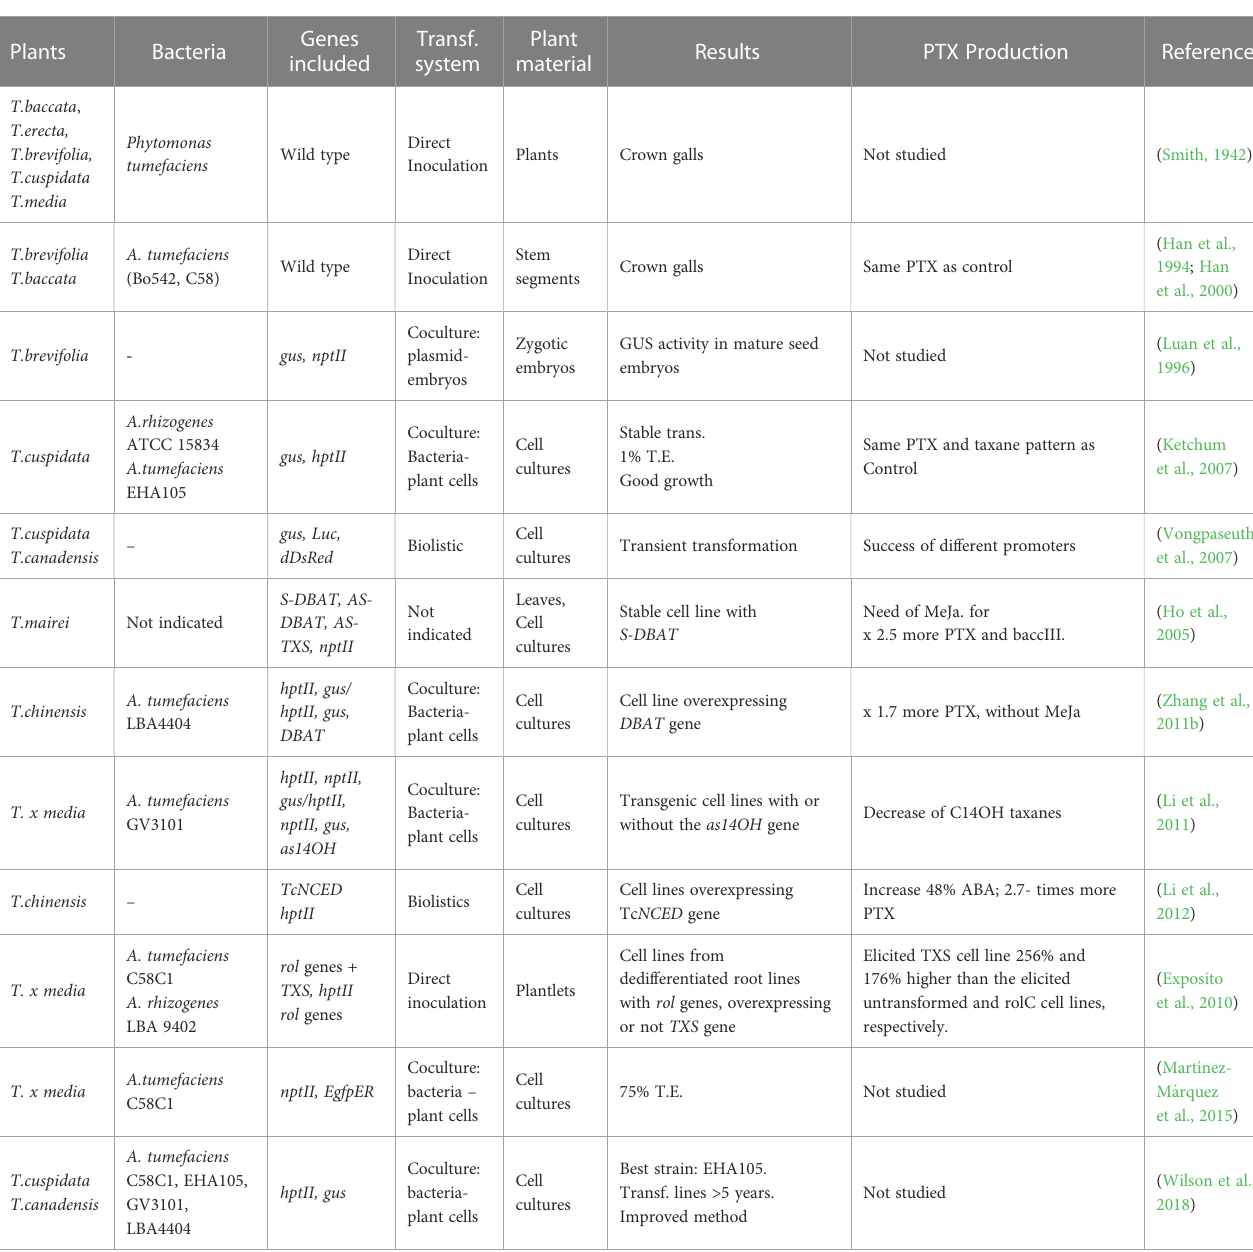
TABLE 1 Transformed Taxus cell